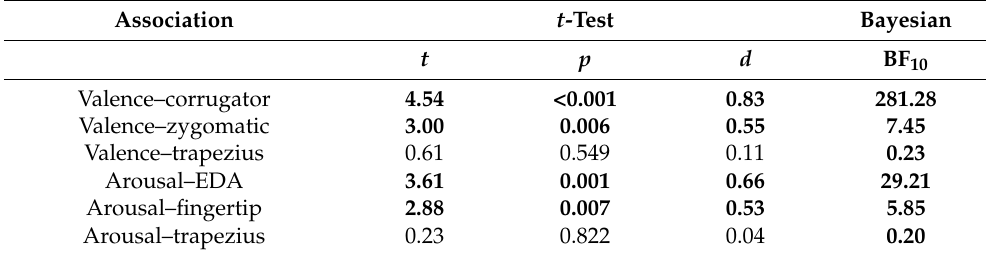
Table 1. Results ofone-sample t -test andBayesian one-sample t -tests ofsubjective–physiological associations.